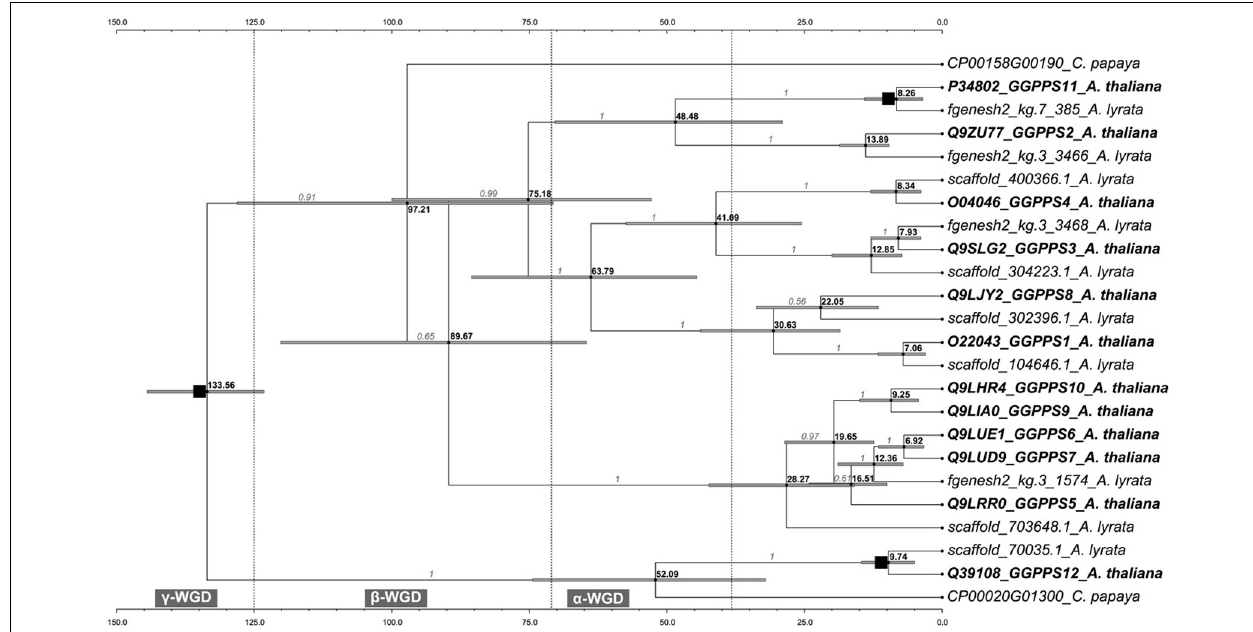
FIGURE 4 | The calibrated GGPPS chronogram. The maximum clade credibility tree and the estimated divergence dates based on total evidence across 24 homologs from A.thaliana , A. lyrata and C. papaya are shown. Branch support values are shown in gray. Note the difference in the relative order between the two clades holding GGPPS2, GGPPS11 and GGPPS5-GGPPS7, GGPPS9, GGPPS10 from Figure 1 . Both topologies in Figures 1 , 4 have high support values but are based on different models of evolution that use amino acid and codon sequences, respectively (see Materials and Methods). Mean divergence dates for all nodes are shown in bold black. Gray bars represent the 95% high posterior density credibility interval for node age. Putative intervals for